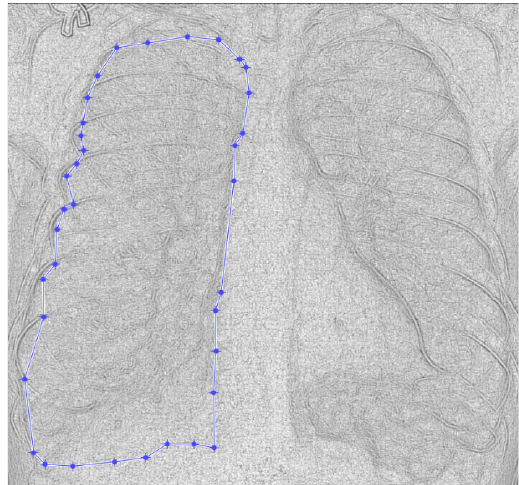
Figure 9. De fi ning the mask for the left lung of the second patient. Figure 9. Defining the mask for the left lung of the second